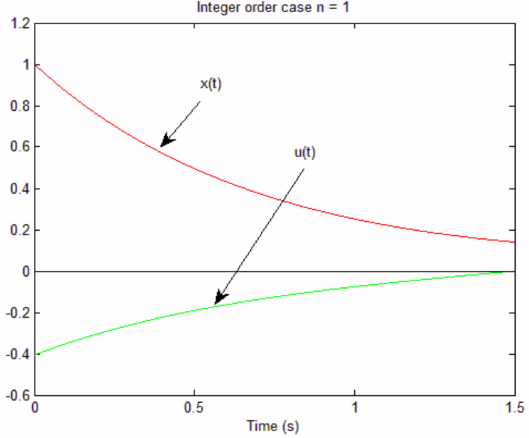
Figure 2. Integer order optimal control. The graphs of z j ( t ) and λ j ( t ) are displayed respectively on Figures 3 and 4 for n = 0.5 j = 0 j = 10 j = 20.